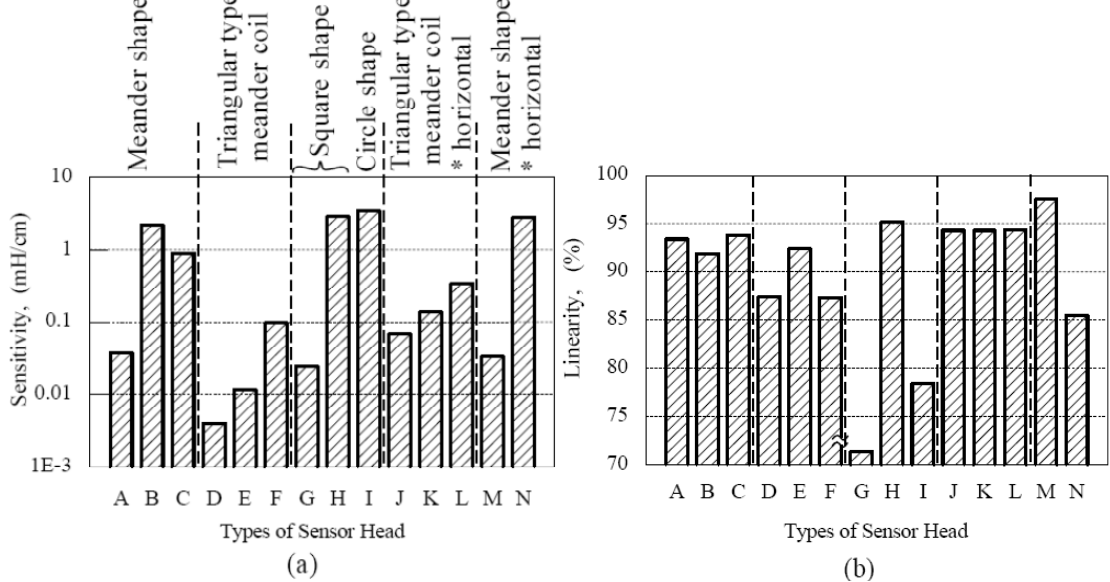
Figure 8. The sensitivity and linearity of various shapes of inductive coil (a) Various shape inductive coil sensitivity; (b) Various shape inductive coil